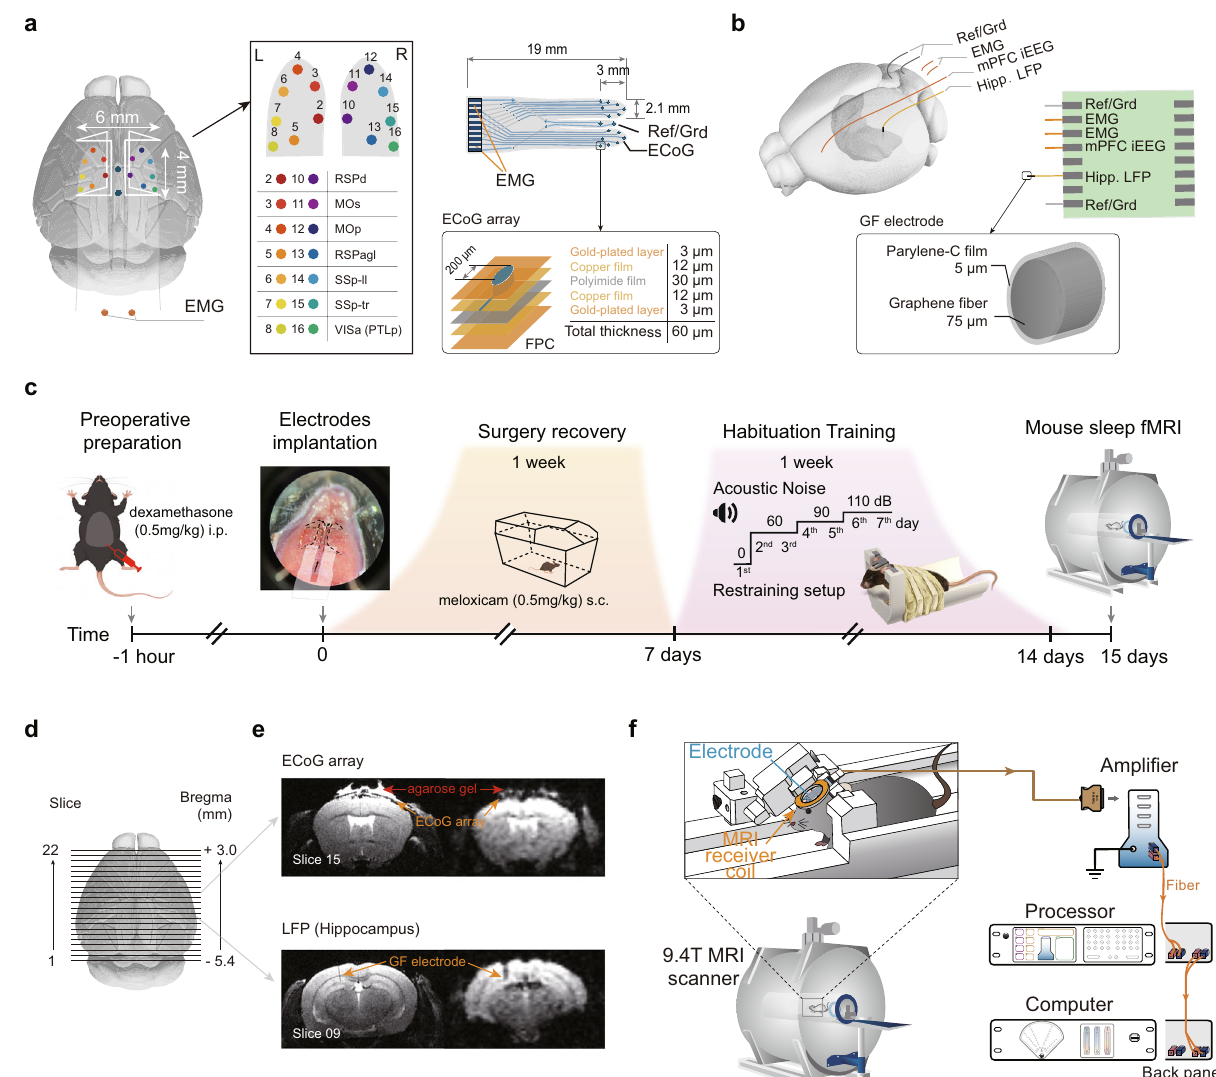
Fig. 1 | Mouse sleep fMRI using MR-compatible electrophysiology recording in un-anesthetized mice. a Design and location of MR-compatible ECoG array. The array was placed above the dura and centered on bregma (length, ~4mm; width, ~6mm) for electrocorticogram (ECoG) recording with two gold wires (orange) insertedinnuchalmusclesforelectromyography(EMG)recording.Rightpanel,the diagram of multi-electrode ECoG array and its layered construction. FPC, fl exible printedcircuit. b Designandlocationofdepthelectrode.Graphene fi ber(GF)based MR-compatibledepthelectrodewasimplantedintothedorsalCA1regionoftheleft hippocampus with gold wires (orange) placed on dura and nuchal muscles for